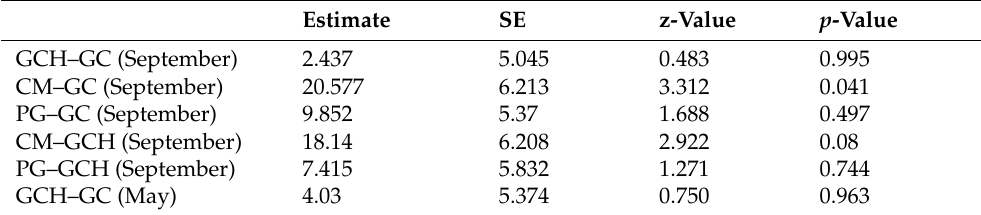
Table A4. Differences in the activity densities of carabid beetles, comparing grass–clover (GC) and grass–clover herbs (GCH) with each other, and in comparison to conventional maize (CM)